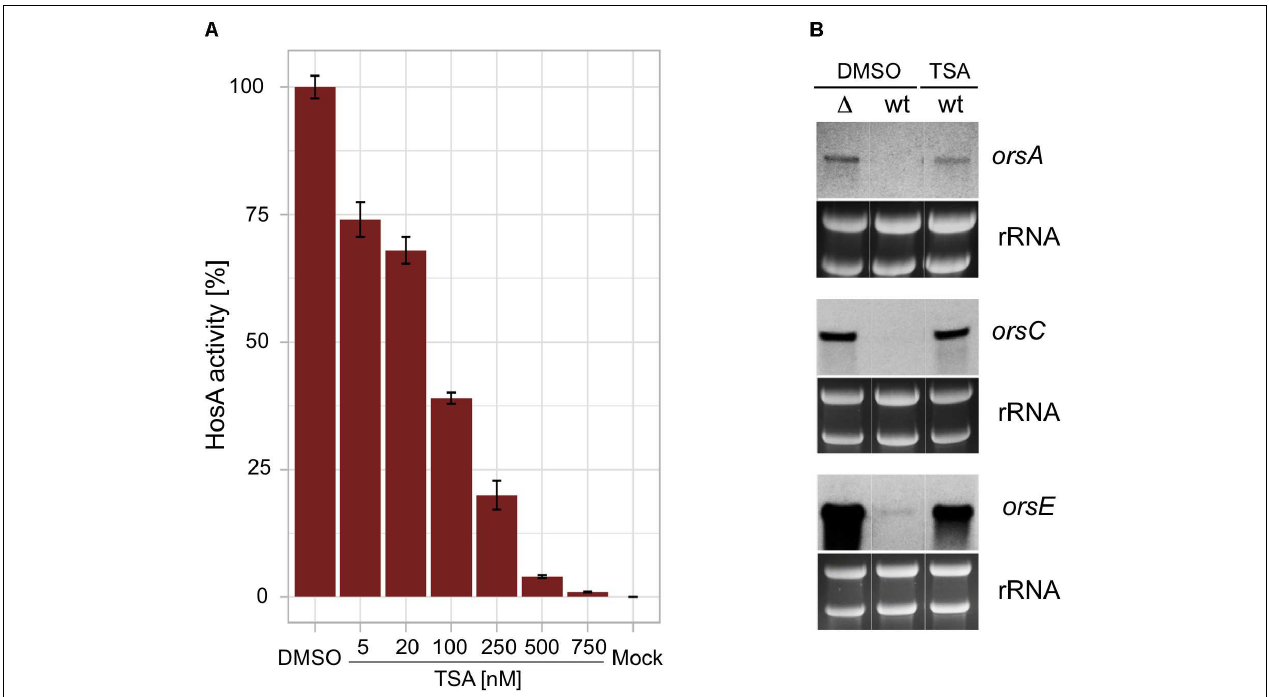
FIGURE 3 | Effect of trichostatin A on the catalytic activity of HosA and the expression of orsellinic acid cluster genes. HDAC activity of purified TAP-tagged HosA was eluted by cleavage with TEV protease and aliquots were used for HDAC activity assays with increasing concentrations of the HDAC inhibitor trichostatin A (TSA). HosA activity with dimethyl sulfoxide (DMSO), the solvent of TSA, was set to 100%, an assay aliquot without recombinant HosA was used as mock control (A) . Expression of the orsellinic acid cluster genes orsA , orsC , and orsE in a wildtype strain with and without TSA treatment. hosA mutant and wt strains were grown in a submerged culture (GMM) for 21 h at 37 ◦ C under iron starvation before 1 µ M TSA (or the corresponding amount of DMSO for the controls) was added to the cultures for additional 3 h. After harvesting of the strains, total RNA was prepared from the mycelia, blotted onto a Hybond-N membrane and hybridized with a digoxigenin-labeled probe against orsA , orsC , and orsE , respectively (B)